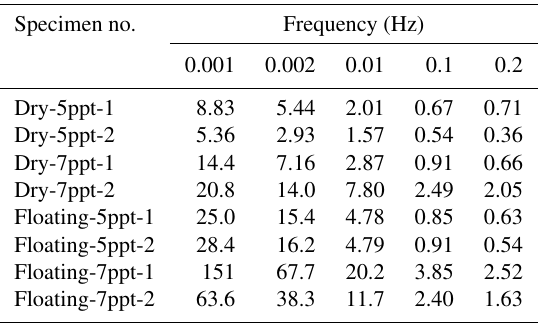
Table 2. The energy density (Jm − 3 ) dissipated in a typical loading– unloading cycle of each experiment. Specimen no.